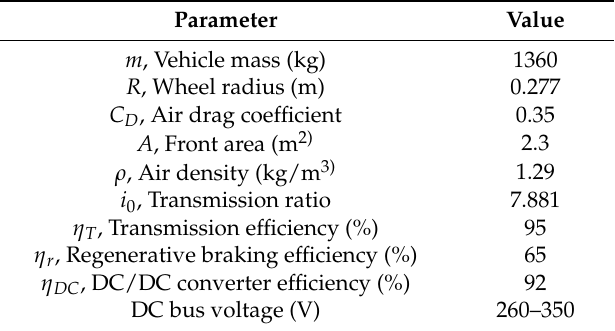
Figure 1. Architecture of the hybrid power system. 123